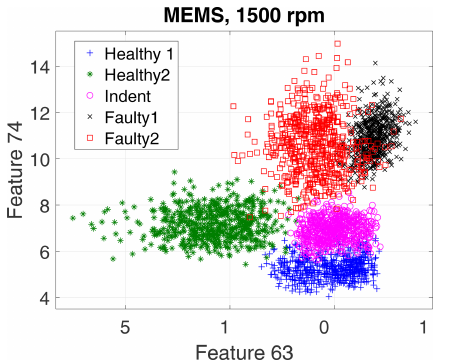
Figure 13. Scatterplot of top two features for the 1500rpm MEMS